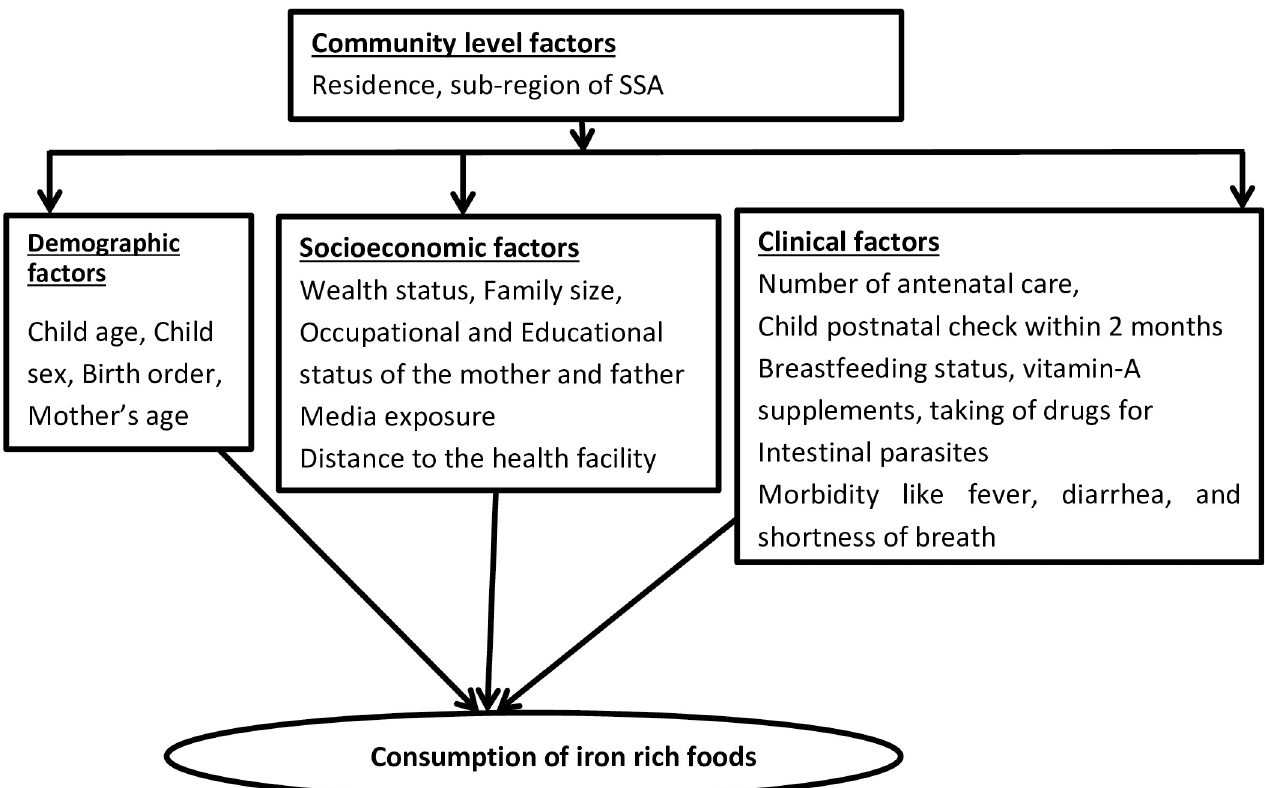
Fig 1. Conceptual framework for factors associated with consumption of iron rich foods in SSA.